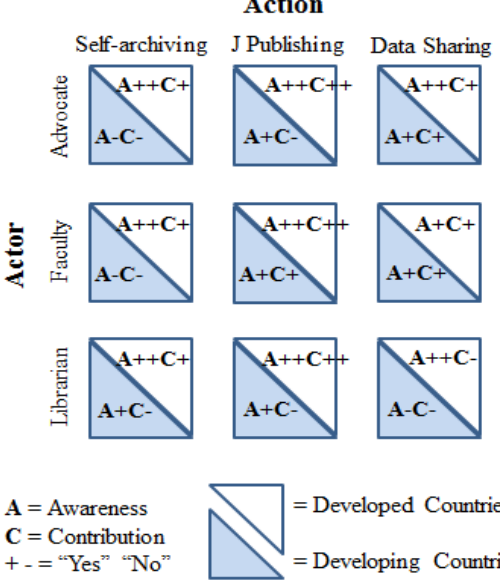
Figure 7. Diagram of a conceptual relationship among the primary variables in the open access divide